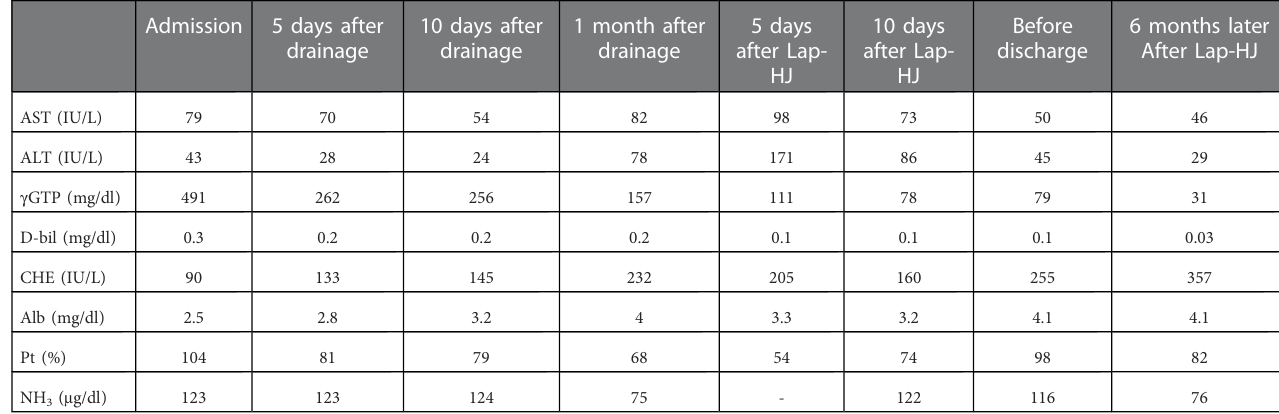
TABLE 1 Changes in blood test data.